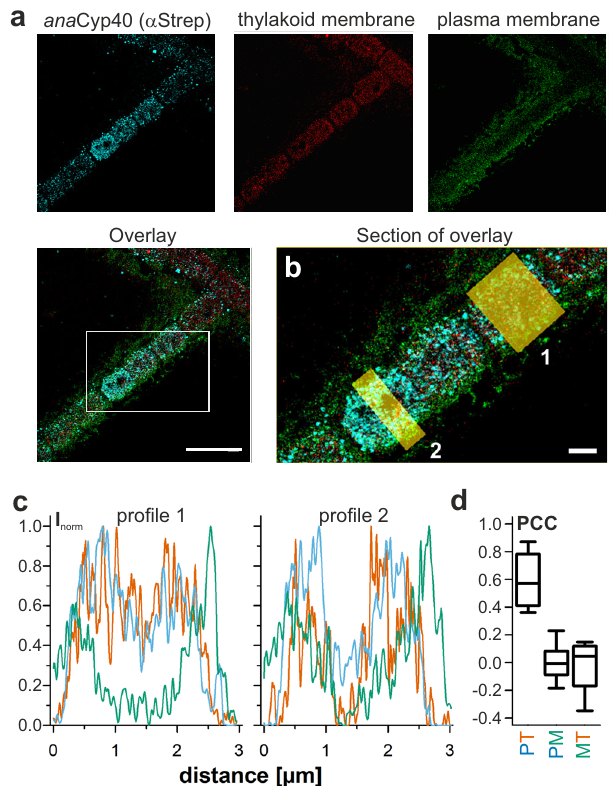
Fig. 5 The intracellular localization of ana Cyp40. a AFS- anaCyp40 -strep was grown in BG11 and processed as described in “ Methods ” . Using three- color super-resolution microscopy, the nanoscale localization of ana Cyp40 (left), the thylakoid membrane (second from left) and the plasma membrane (second from right) were visualized (overlay shown on the right, scale bar = 5 µ m). b Enlarged section as indicated in ( a ) with two boxed regions (1, 2) from where intensity pro fi les were extracted (scale bar = 1 µ m). c Intensity pro fi les for the two regions shown in ( b ) for ana Cyp40 (cyan), the thylakoid membrane (red) and the plasma membrane (green) are shown. d The Pearson correlation coef fi cient (PCC) was calculated from intensity values for pixels and for ana Cyp40 and thylakoid (PT), ana Cyp40 and membrane (PM) as well as for the membrane and thylakoid (MT). Values were calculated in 10 individual regions and are shown as box plot (horizontal lines indicate median, box sizes represent the 25th and 75th percentile of all values, whiskers indicate the standard deviation). Source data are provided as a Source data fi